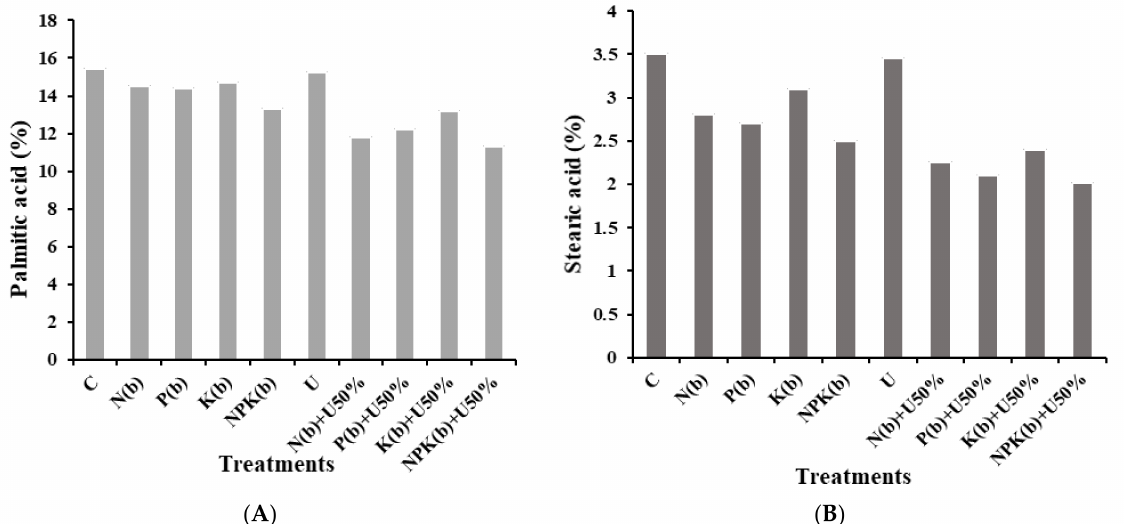
Figure 5. Means comparison for palmitic acid ( A ) and stearic acid ( B ) of Nigella sativa L. as influenced by biofertilizers and chemical urea (chemical urea fertilizer (U), biofertilizer N (b) , biofertilizer P (b) , biofertilizer K (b) , mixed biofertilizer NPK (b) , 50% urea + biofertilizer N (N (b) + U 50% ), 50% urea + biofertilizer P (P (b) + U 50% ), 50% urea + biofertilizer K (K (b) + U 50% ), and 50% urea + biofertilizer NPK (NPK (b) + U 50% )).